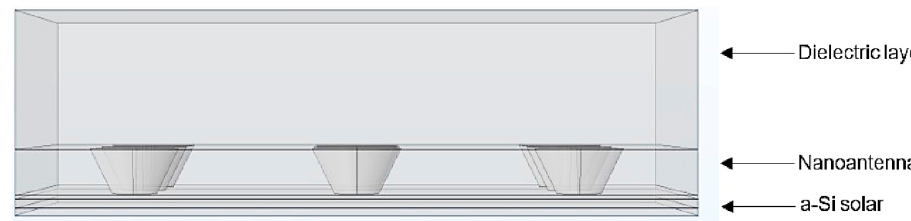
Figure 11. Side view of the 3D a-Si solar cell structure with nanoantenna with conical holes.